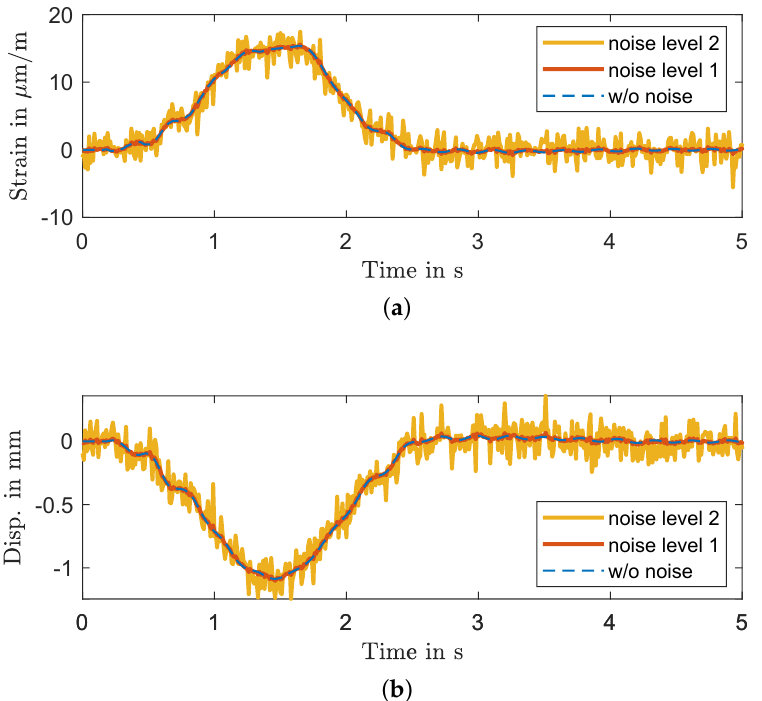
Figure 9. Exemplary crossing with the first 5s for different noise levels. The selected crossing represents the median with 17.7t. This means that half of the simulated crossings have worse SNR and half of the simulated crossings have greater SNR. ( a ) Strain in x direction for sensor position S4. ( b ) Displacement in z direction for sensor position